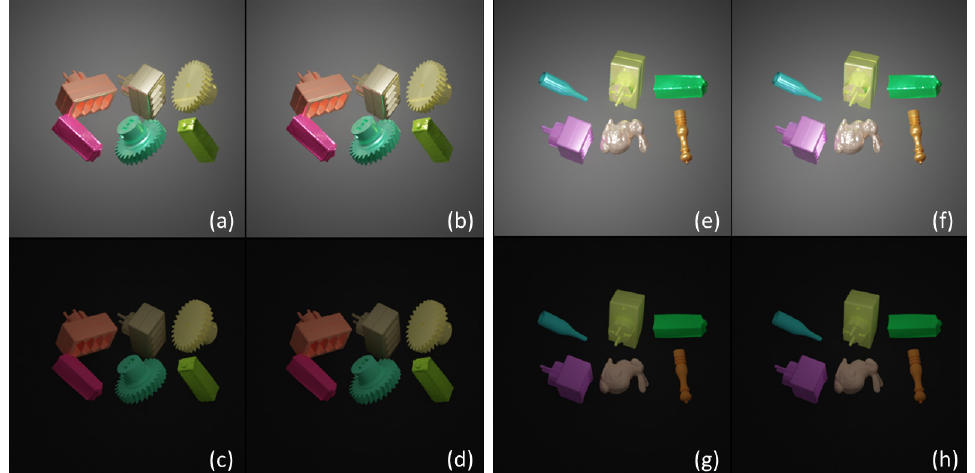
Figure 3. Two examples of synthetically generated data. ( a , e ) Camera 1 image with specular re- flections; ( b , f ) Camera 2 image with specular reflections; ( c , g ) Image without specular reflection corresponding to ( a , e ); ( d , h ) Image without specular